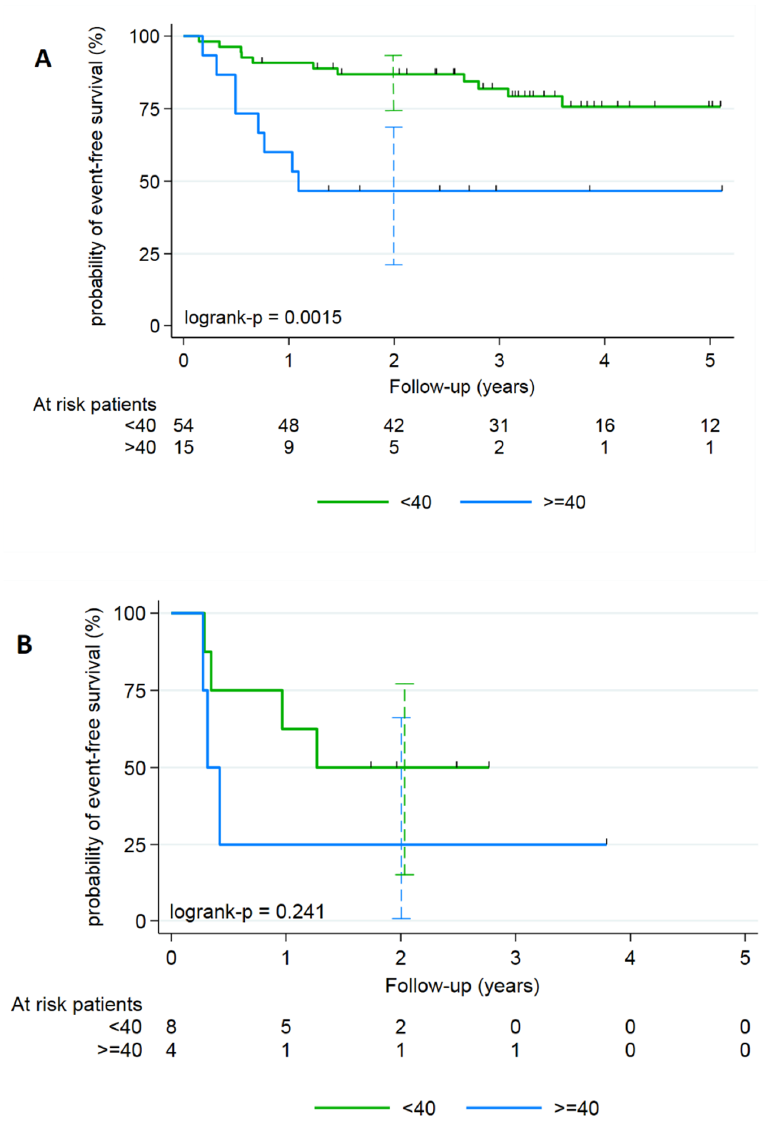
Figure 1. Kaplan–Meier analyzes of the EFS for anal SCC according to the T-MTV defined with a segmentation of 35% of the SUVmax threshold and stratified on gender: ( A ) female population and ( B ) male.